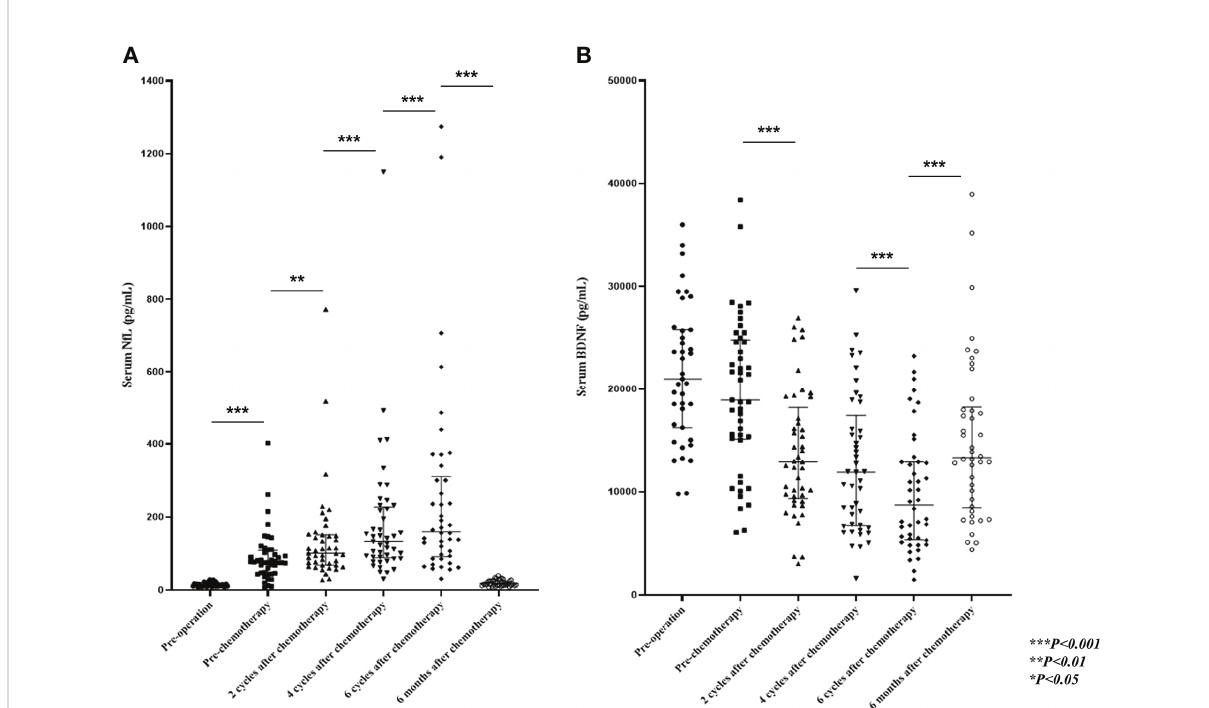
FIGURE 3 Evaluation of sNfL and sBDNF levels. Shown are the median (IQR), (A) sNfL, and (B) sBDNF levels during and 6 months after paclitaxel treatment. P-values were calculated using the Wilcoxon signed-rank test. sNfL, serum neuro fi lament light chain; sBDNF, serum brain-derived neurotrophic factor; IQR, interquartile